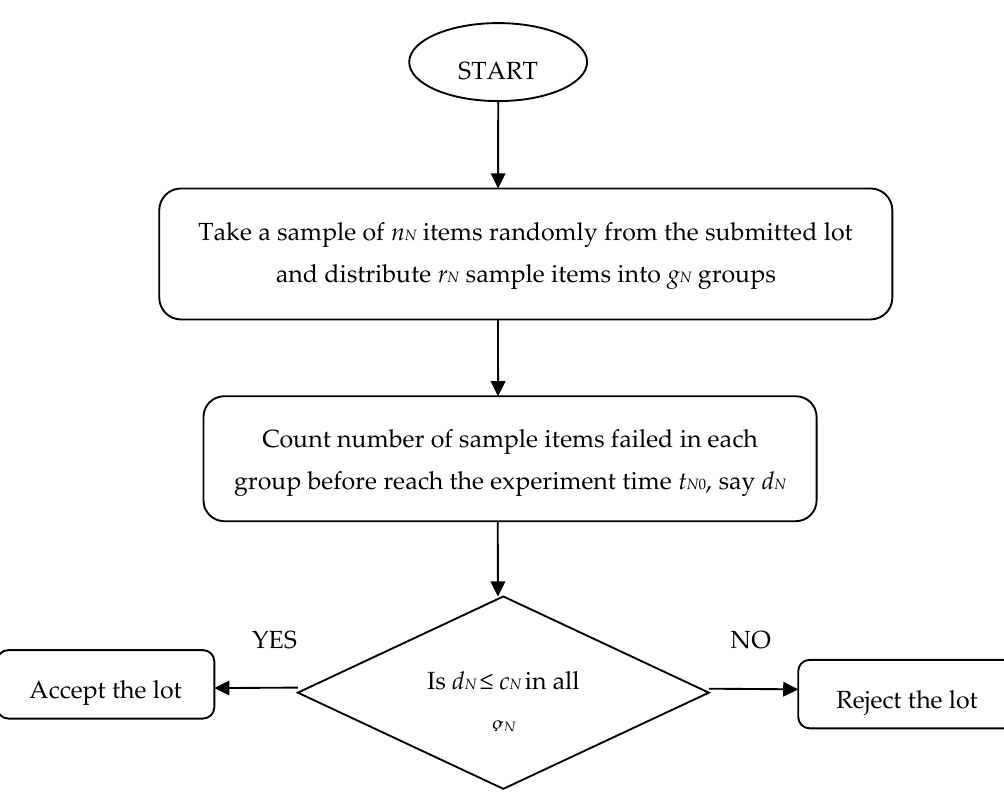
Figure 1. Operating procedure of the proposed group acceptance sampling plan (GASP) under a truncated life test.